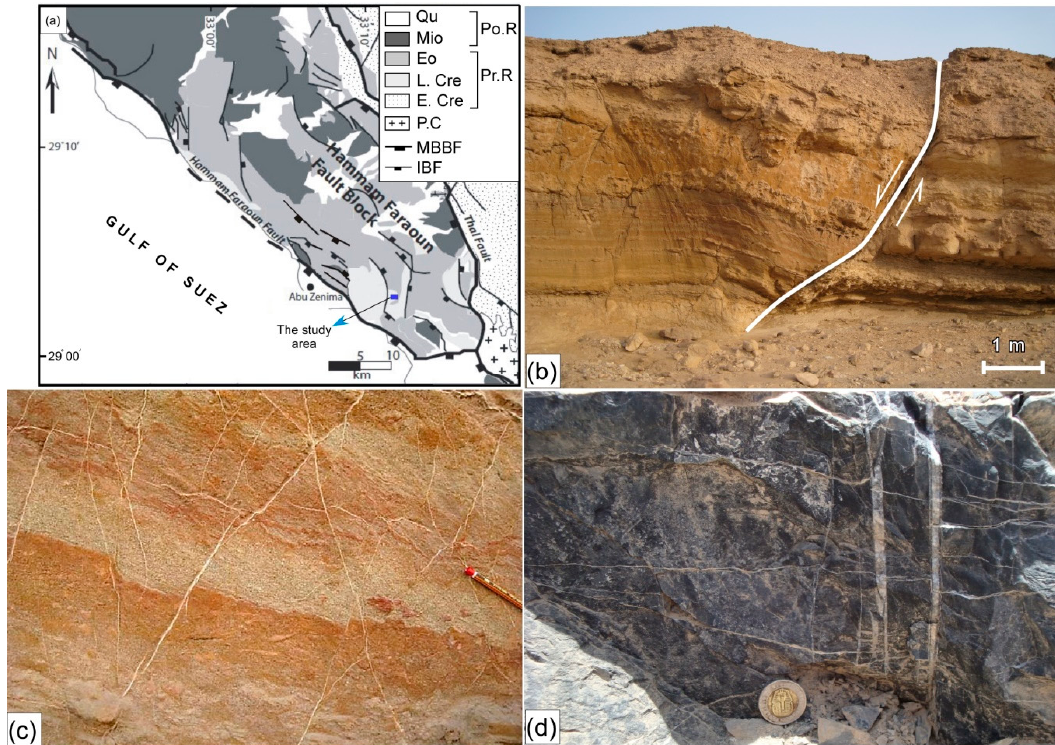
Figure 3. ( a ) A generalized structural map of the Hammam Faraun Fault Block ( modified after Bastesen et al., 2015 [56]). ( b ) N70W-trending flat and ramp listric fault cut through the Matulla Formation. Note the ramp and flat segments of the fault, the rollover anticline and the hangingwall deformation and the footwall duplex. View is to the NW. ( c ) Conjugate calcite-filled shear fractures showing minor displacements, and well-developed step and graben geometries. Pencil is 12 cm long. ( d ) Black limestone dissected by two perpendicular sets of fractures. The vertical fractures are variably sized and filled with calcite. The coin diameter is 2.5 cm. ( QU: Quaternary; Mio: Miocene; Eo: Eocene; L.